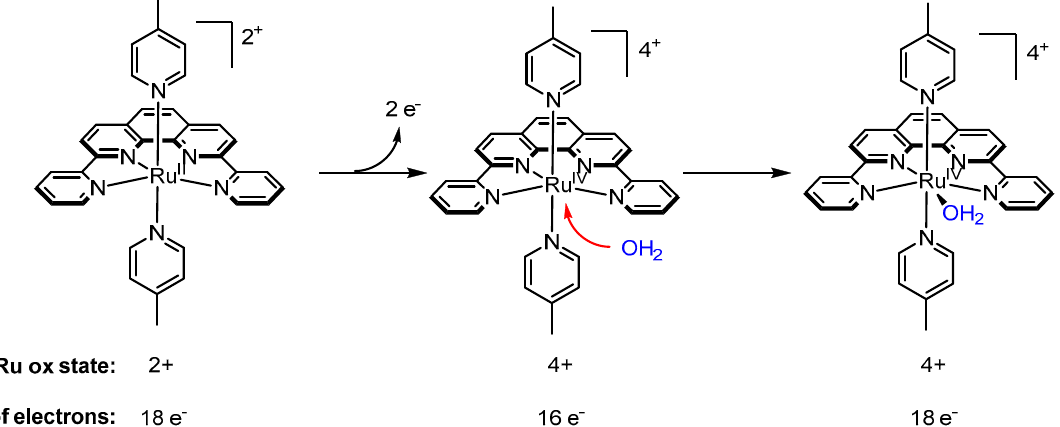
Figure 11. Thummel’s hypothesis on the mechanism of water oxidation by 21 .